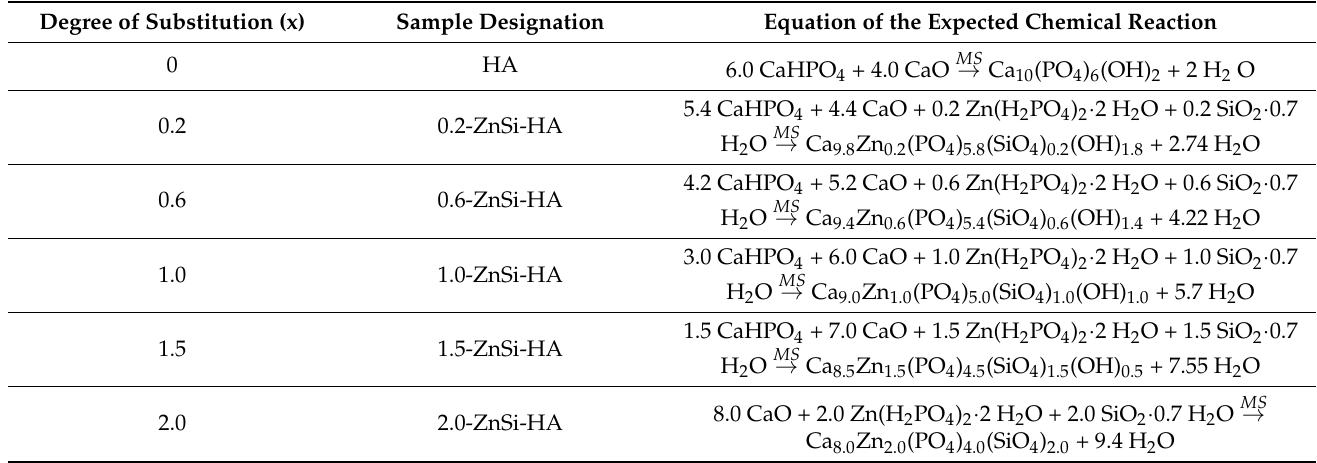
Table 1. Ratio of the initial reagents and expected product of the mechanochemical